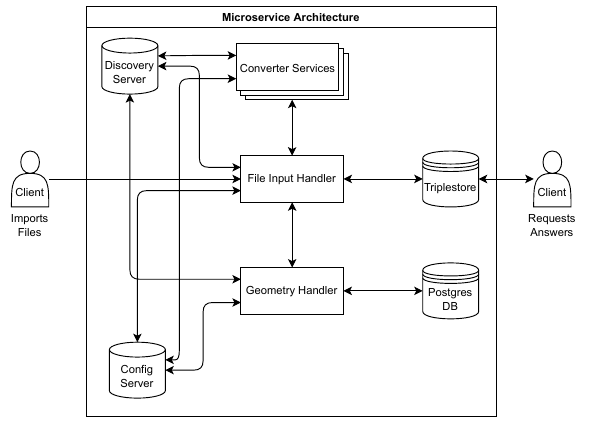
Figure 1. The basic microservice architecture and the connections between components. Clients can interact with the File Input Handler and the Triplestore.